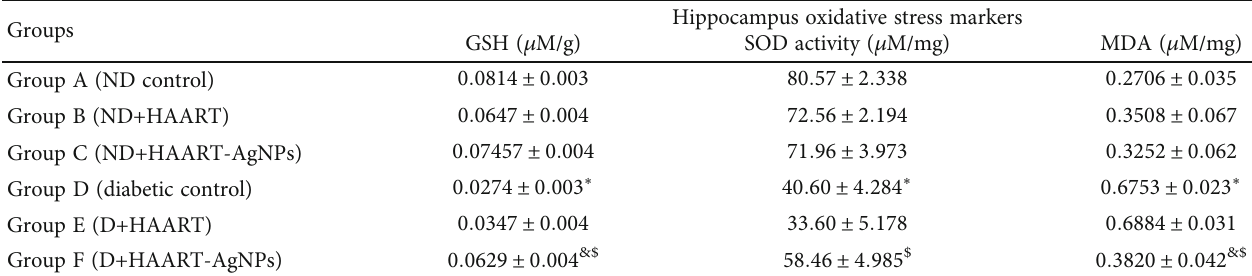
Data are expressed as mean ± SEM ( n = 8 ); ∗ p < 0 : 05 vs. group A (nondiabetic control), & p < 0 : 05 vs. group D (diabetic control); $ p < 0 : 05 vs. group E (diabetic +HAART). ND= nondiabetic; D=diabetic.